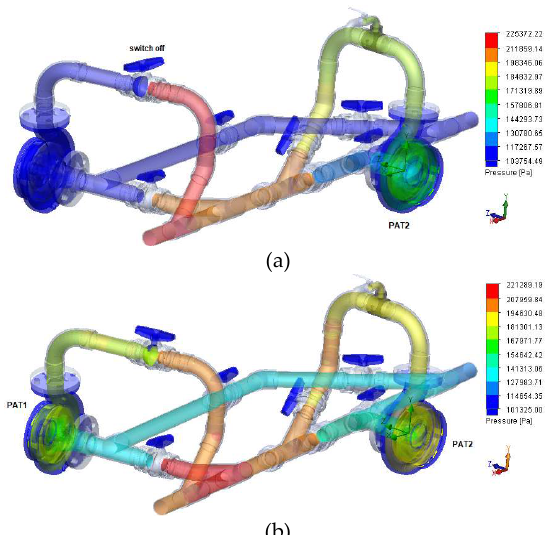
Figure 12. Pressure variation of the single PAT2 operation for the best efficiency point (BEP) ( a ); and for the parallel mode (N1 = 440 rpm and Q1 = 2.93 L/s) for PAT1 and (N2 = 735 rpm and Q2 = 3.77 L/s) for PAT2 ( b ).